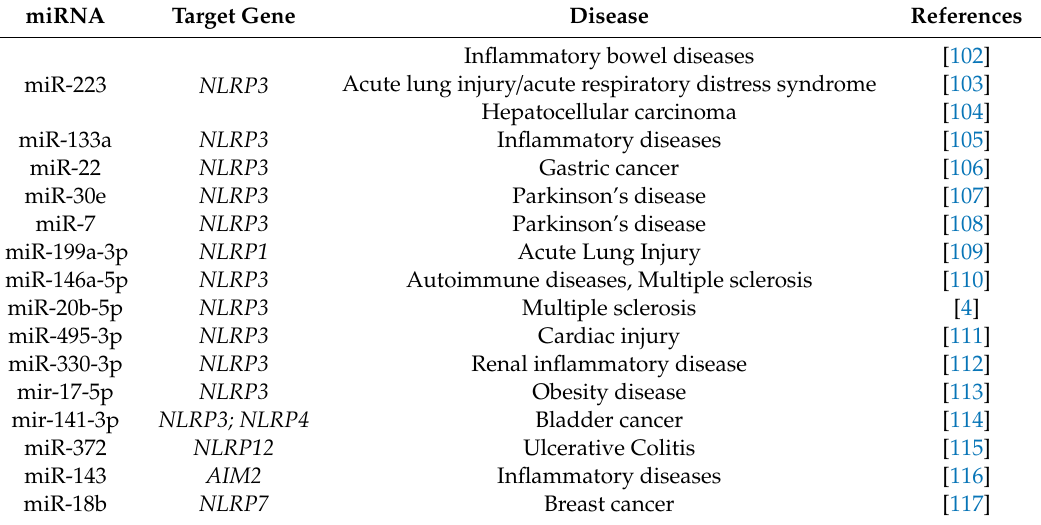
Table 1. List of miRNAs known to target inflammasome genes and associated diseases. NLR, NOD-like